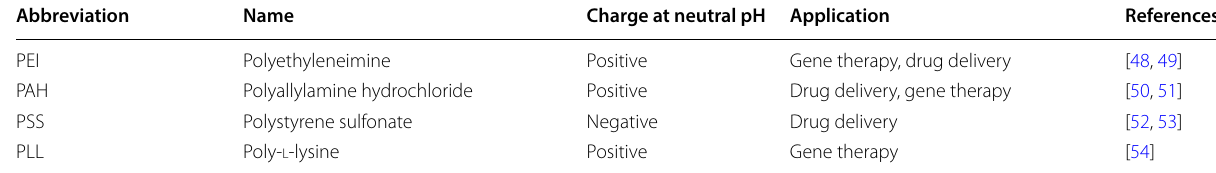
Table 1 Commonly used polyelectrolytes showing their charge at pH 7 and their current